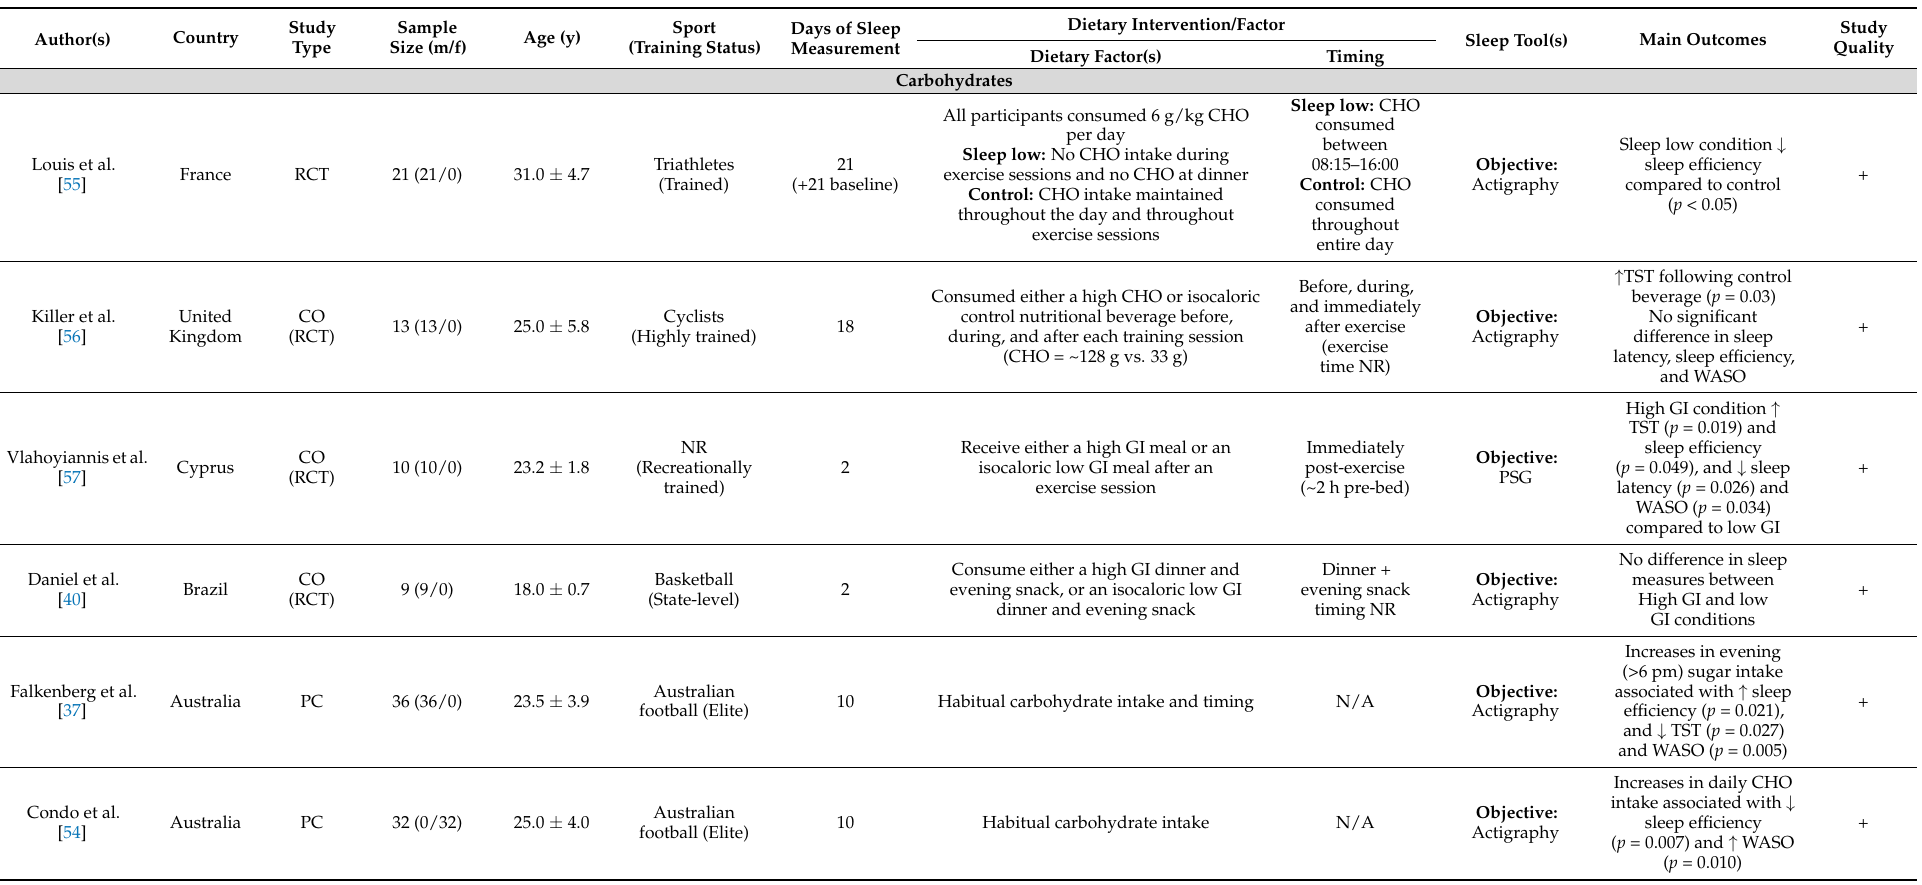
Table 2. Studies investigating the influence of macronutrients, micronutrients, and energy on the sleep of athletically trained